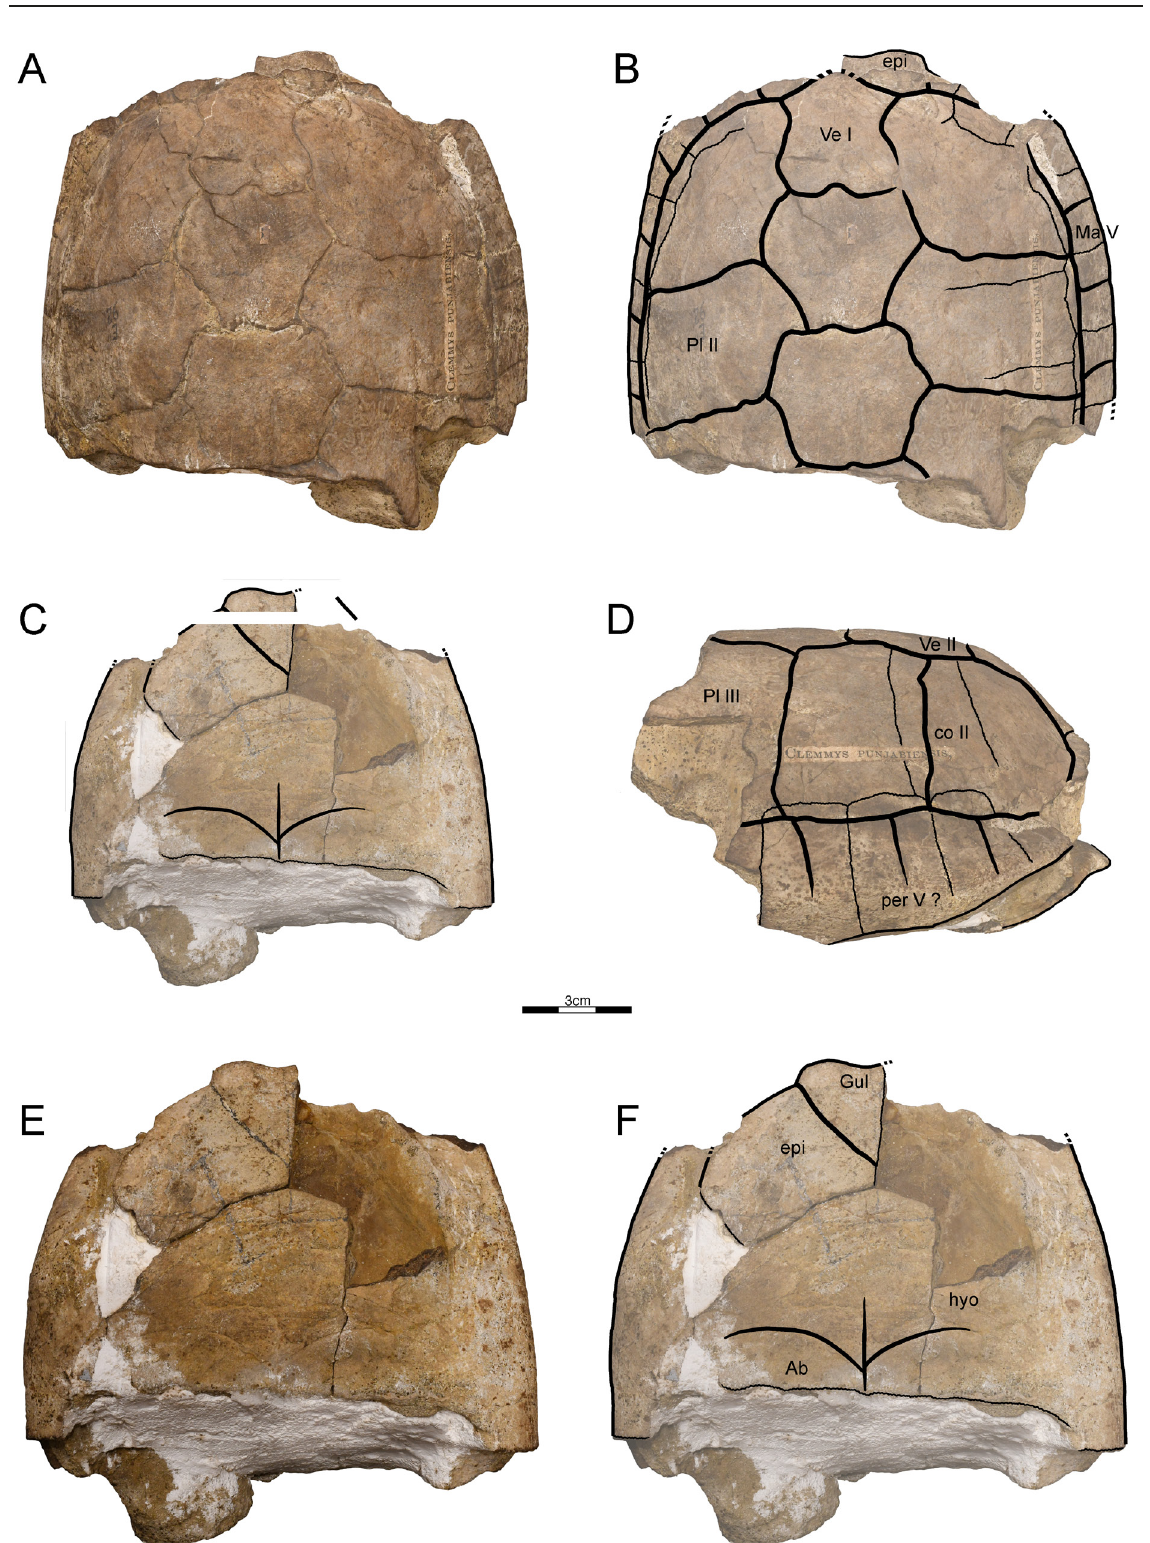
Fig. 30. IM E.92, holotype of Clemmys punjabiensis Lydekker, 1885, here identified Melanochelys sivalensis (Theobald, 1877) comb. nov. A . Photograph of carapace. B . Illustration of carapace. C . Photograph of carapace in lateral view. D . Illustration of carapace in lateral view. E . Photograph of plastron. F . Illustration of plastron. Scale bar: